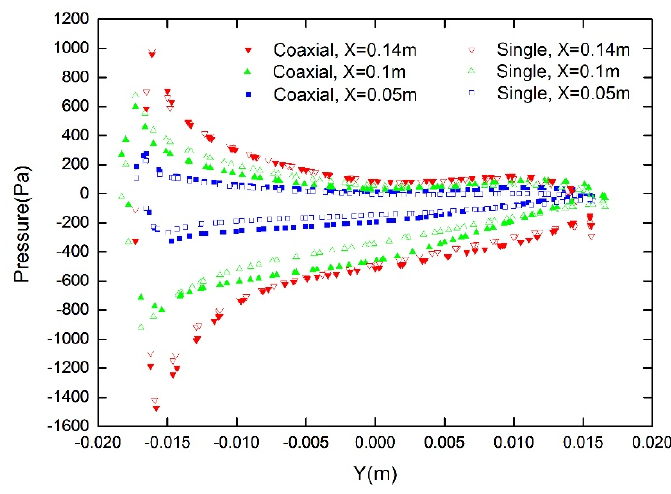
Figure 8. Calculated surface pressure of single and coaxial upper propellers.